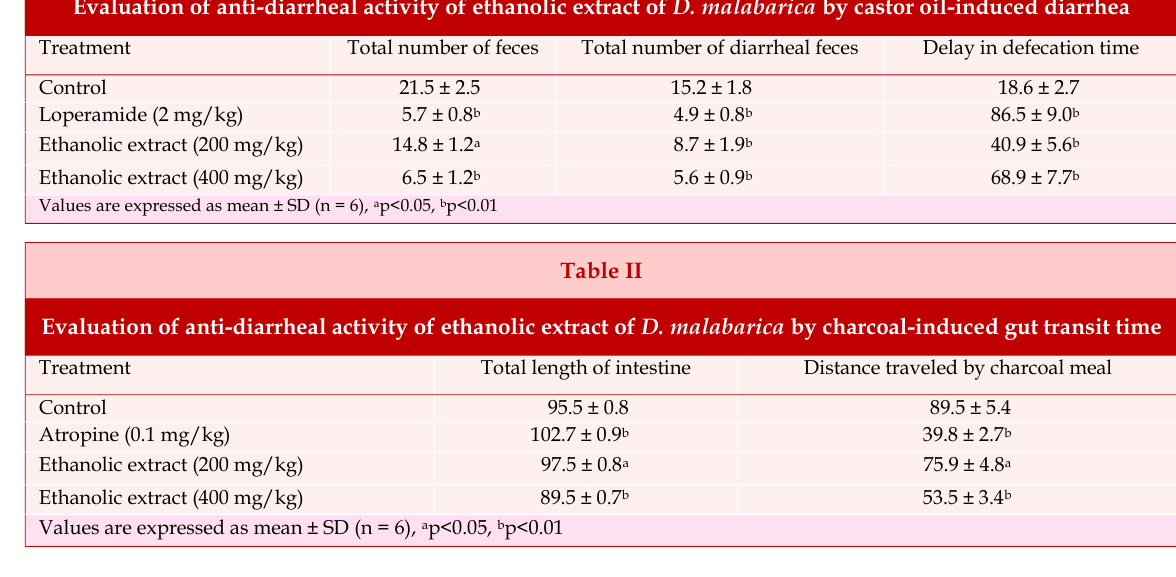
The ethanolic extract (200 and 400 mg/kg) dose depen- dently reduced the intestinal fluid accumulation with respect to PGE 2 control group. The effect of extract at dose of 400 mg/kg was found to be more potent when compared with standard and control. There was signifi- cant increase in intestinal fluid accumulation was seen in PGE 2 control group when compared to negative con- trol received only ethanol in normal saline (Table III).